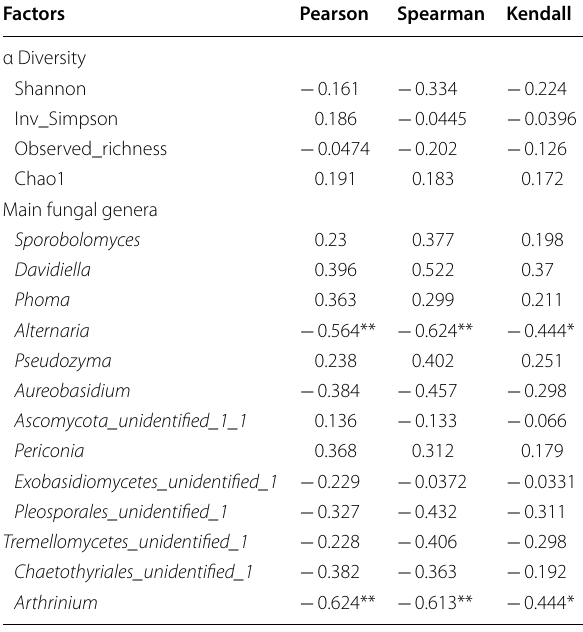
Table 2 Correlation analysis between lesion coverage rate (LCR) and α diversities index and main genus of